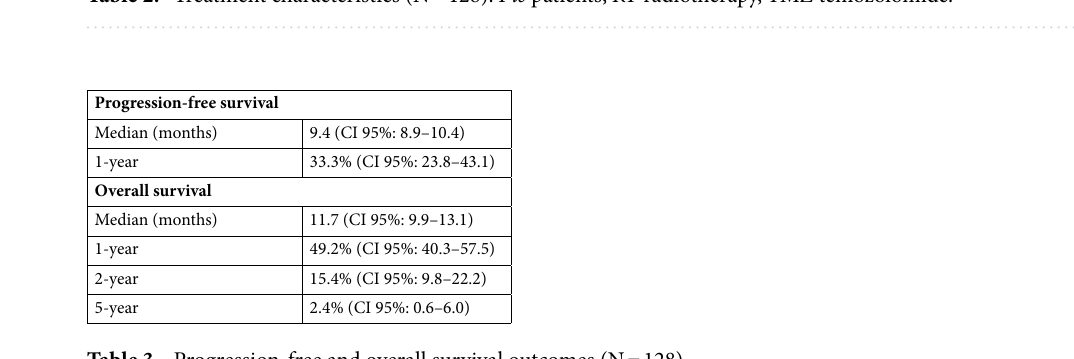
Table 2. Treatment characteristics (N = 128). Pts patients, RT radiotherapy, TMZ temozolomide.